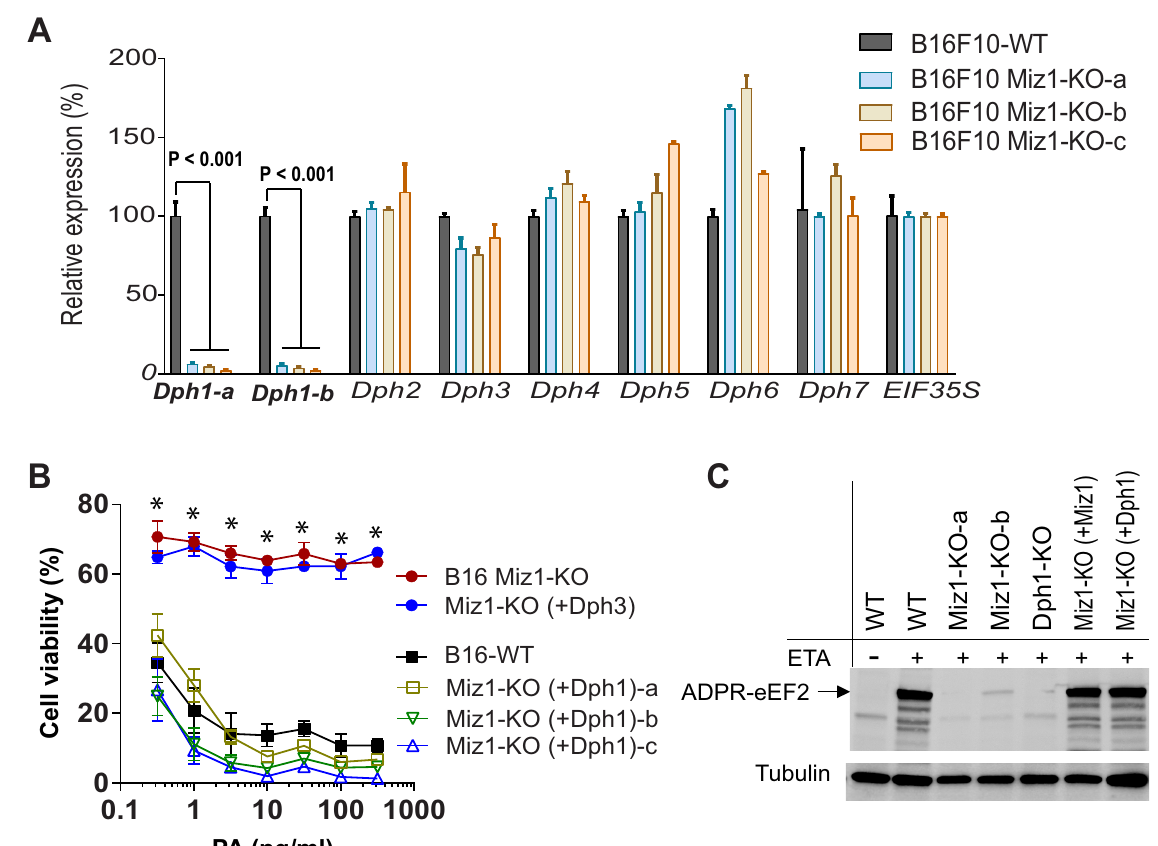
Fig 4. Miz1 is required for diphthamide biosynthesis through direct transcriptional regulation of Dph1 expression. A . Real-time PCR analyses of the seven known Dph genes’ expression in B16F10 WT and Miz1-KO cells. Eukaryotic translation initiation factor EIF35S was used as an internal normalization control. Of note, Dph1 expression is diminished in all Miz1-KO cells. Two set of Dph1 primers were used for a confirmational purpose (a, b). Three independent B16F10 Miz1-KO clones were analyzed. Data are represented as mean (triplicate) ± SD. Of note, B16F10 Miz1-KO cells exhibited consistent diminished Dph1 expression. Unpaired two-tailed Student’s t -tests. B . Exogenous expression of Dph1 in B16F10 Miz1-KO cells reverts their toxin-resistant phenotype. B16F10 Miz1-KO cells were transfected with Dph1- or Dph3-expressing plasmid. Cells were incubated with various concentrations of PA in the presence of FP59 (100 ng/ml) for 48 h, followed by an MTT assay evaluating cell viability. Three independent B16 Miz1-KO- (+Dph1) clones were analyzed. Data are represented as mean (triplicate) ± SD. Unpaired two-tailed Student’s t -tests, � , p < 0.001 between B16F10 Miz1-KO cells and their isogenic Dph1 transfected cells. C . eEF2 from B16F10 Miz1-KO cells regains the ADP-ribose acceptor ability via transfection with either a Dph1- or Miz1-expression construct. The indicated cell lysates were treated with FP59 (100 ng/ml) in the presence of biotin-labelled NAD + for 30 min and then analyzed by Western blotting using streptavidin-IR conjugate. Representative of three independent